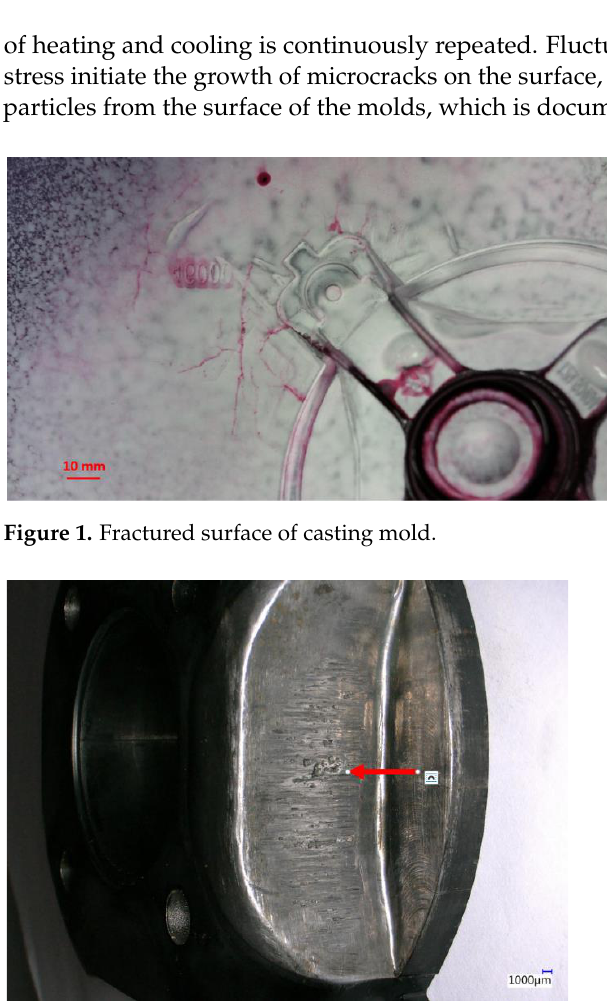
Figure 2. Degraded surface of high pressure die casting mold.